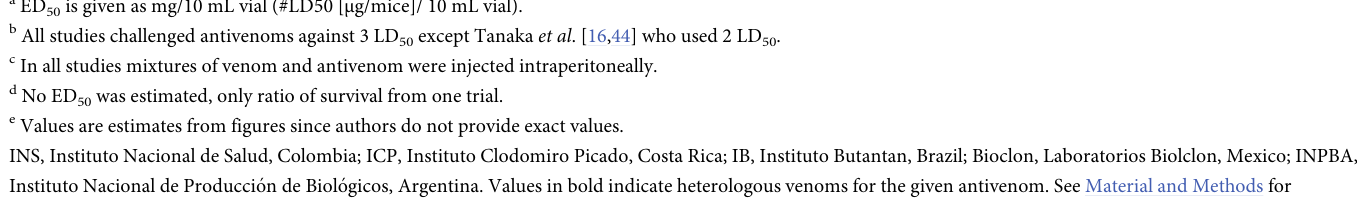
Micrurus species